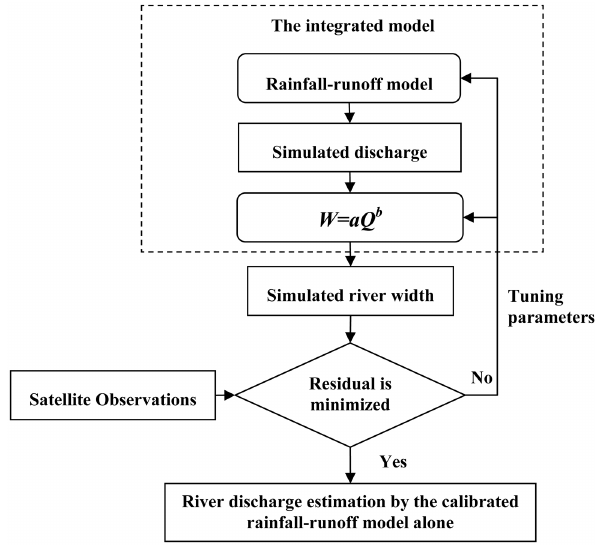
Fig. 1. Flowchart of the proposed framework for river discharge